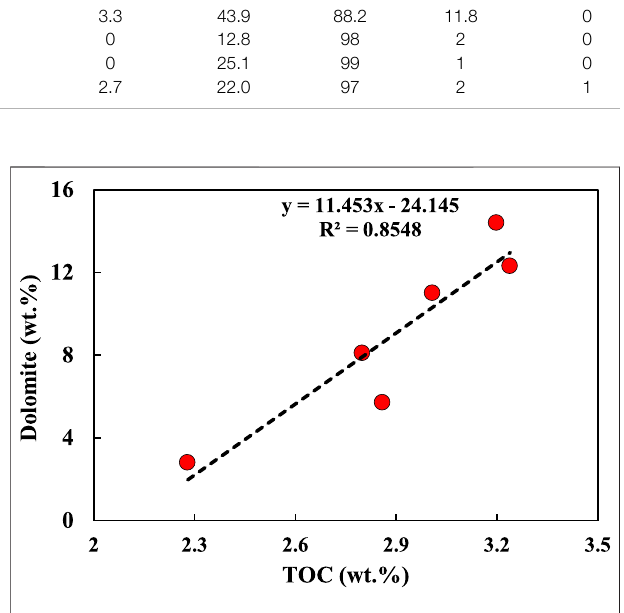
FIGURE 1 | Cross-plot of TOC and dolomite